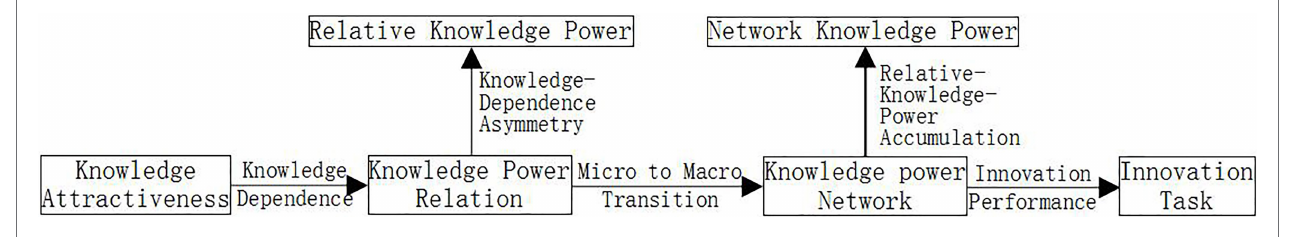
FIGURE 1 | The formation path of knowledge